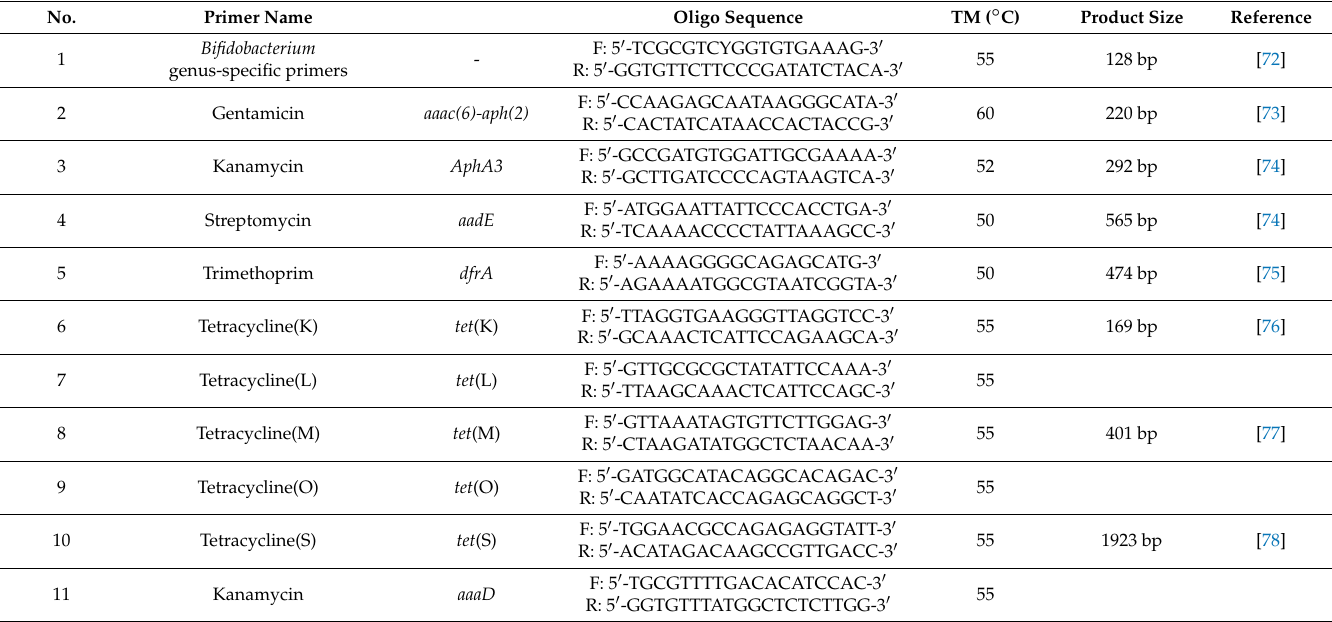
Table 9. Primers and conditions for PCR detection 1